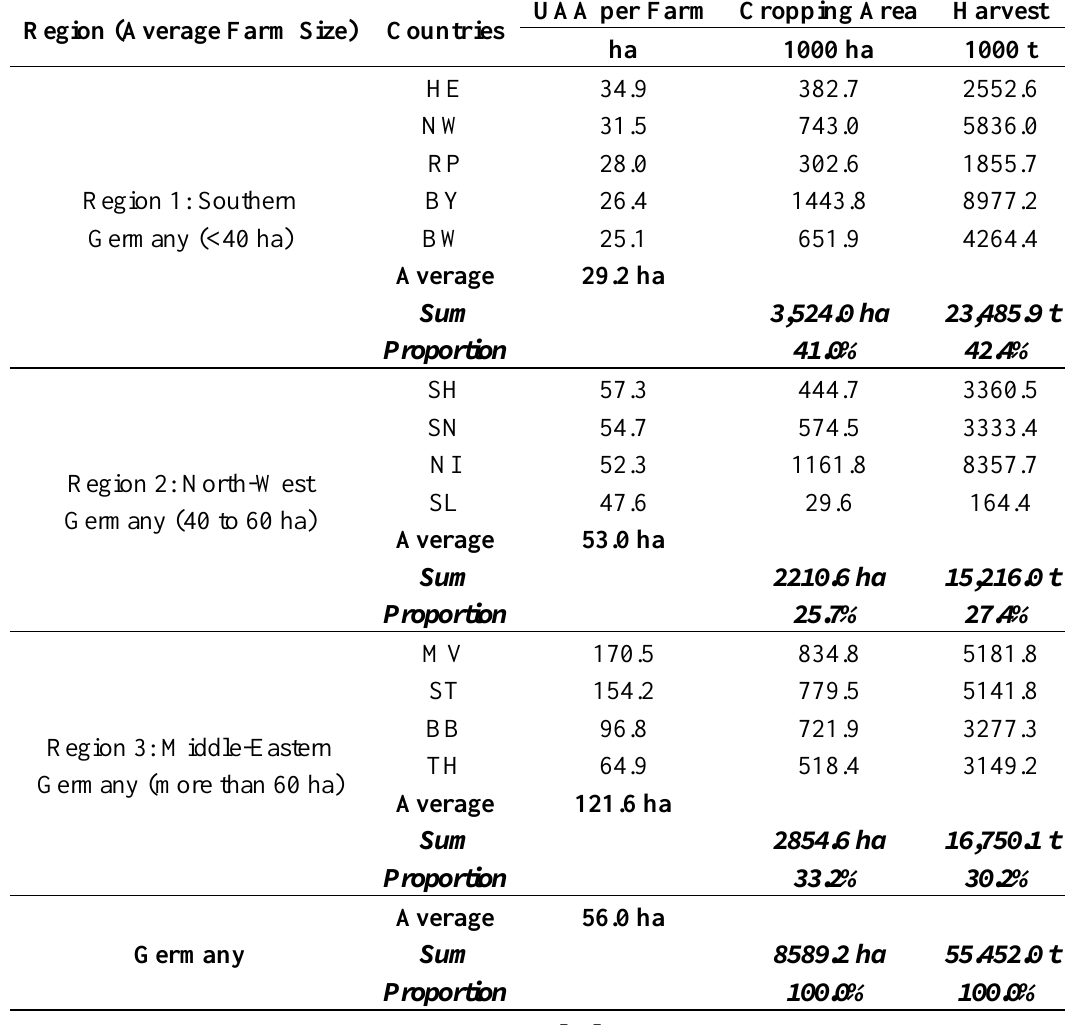
Table 3. Combine sizes in relation to the operational structure (farm size) in the regions. Regions in